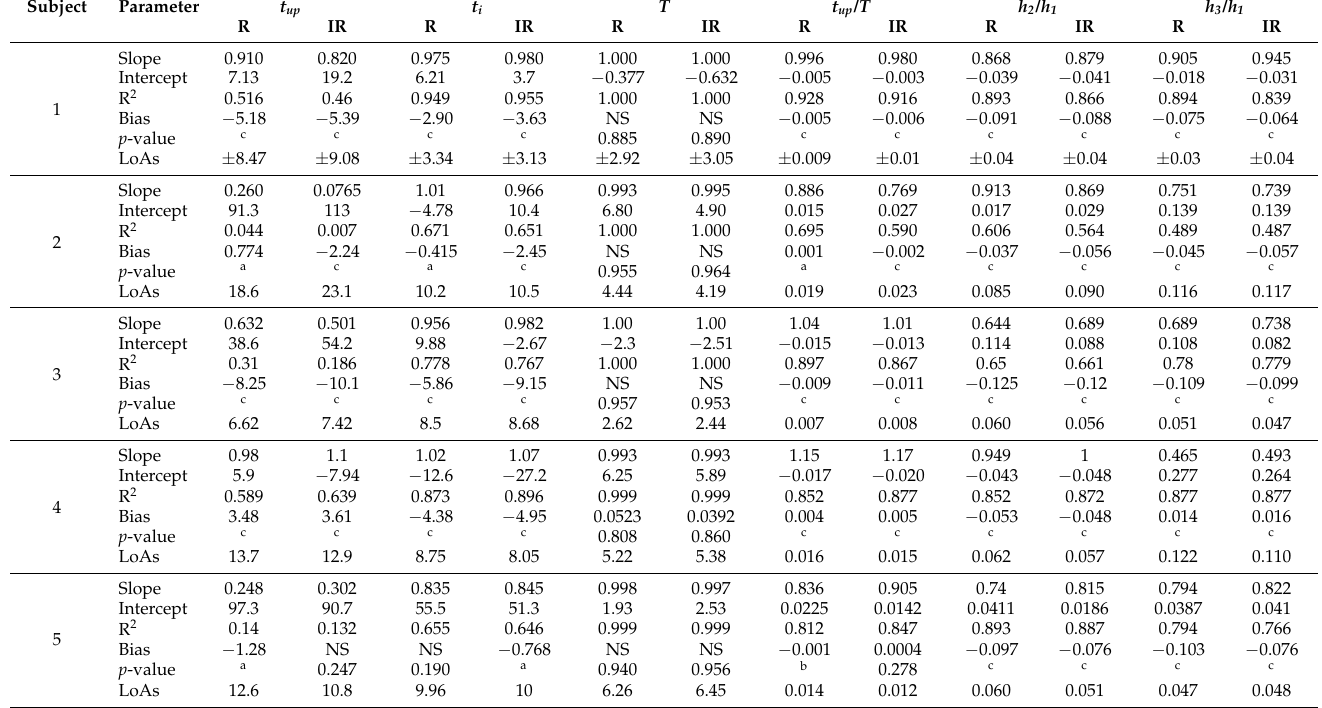
Table 6. Results of the regression, correlation, and Bland–Altman analyses that were carried out to compare the morphological parameters of PW signals provided by FCG and PPG sensors for each subject. Intercept, bias, and LoAs for t up , t i , and T are expressed in milliseconds. Non-significant bias is indicated as